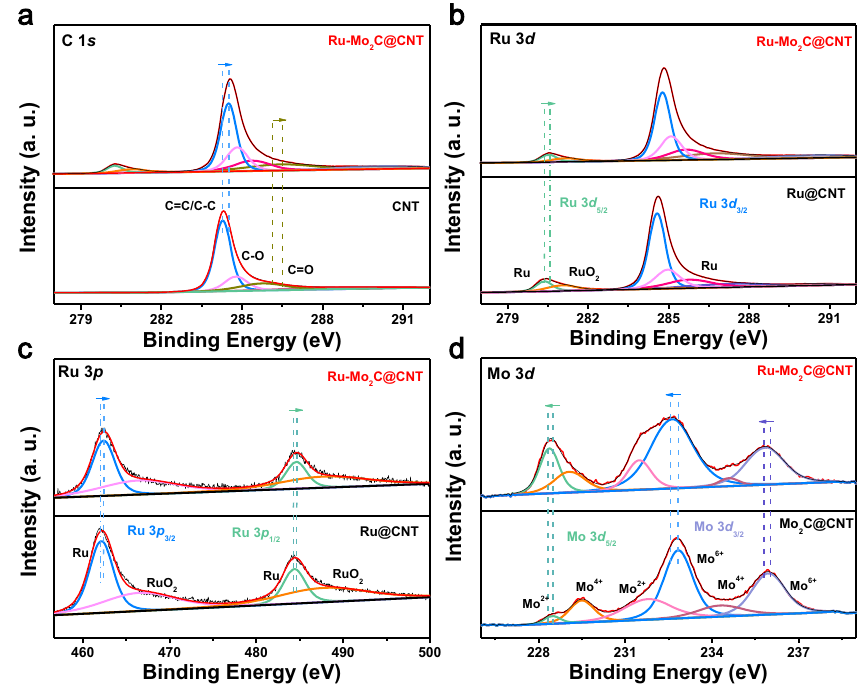
Fig. 2 High-resolution XPS spectra of Ru-Mo 2 C@CNT. a High-resolution XPS spectrum of C 1 s of CNT and Ru-Mo 2 C@CNT. b High-resolution XPS spectrum of Ru 3 d spectra of Ru@CNT and Ru-Mo 2 C@CNT. c High-resolution XPS spectrum of Ru 3 p of Ru@CNT and Ru-Mo 2 C@CNT. d